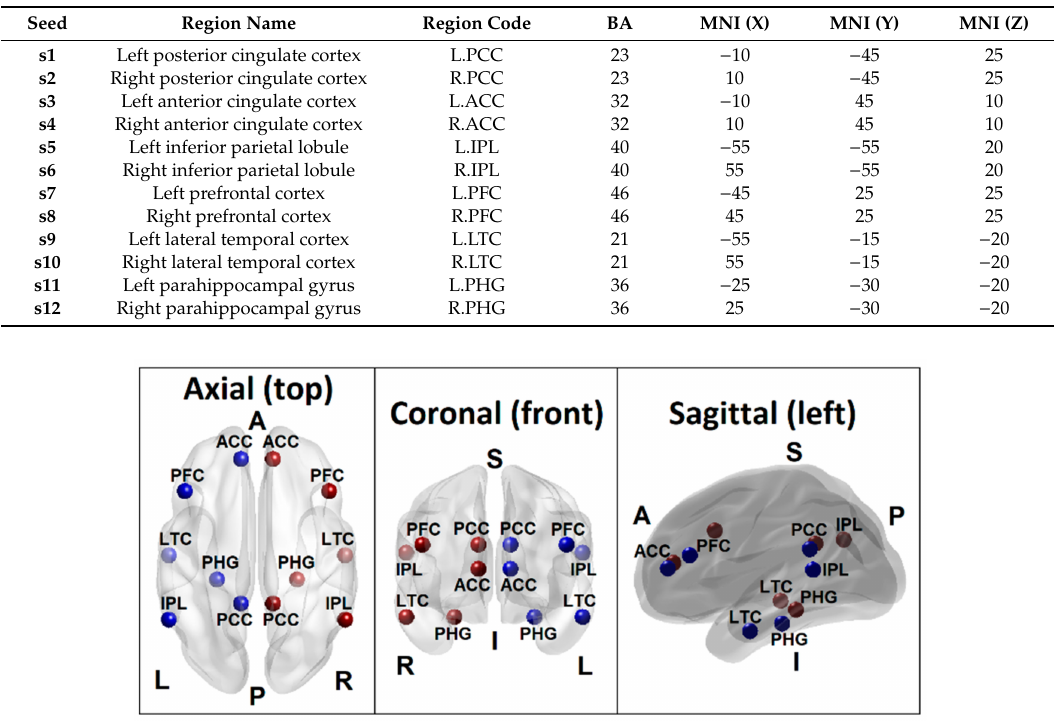
Figure 1. Seed regions of the DMN consisting of 6 regions in the left hemisphere (blue beads) and 6 homologous regions in the right hemisphere (red beads), as listed in Table 1. Axial (top), coronal (front), and sagittal (left side) views are shown. (PCC–Posterior cingulate cortex;